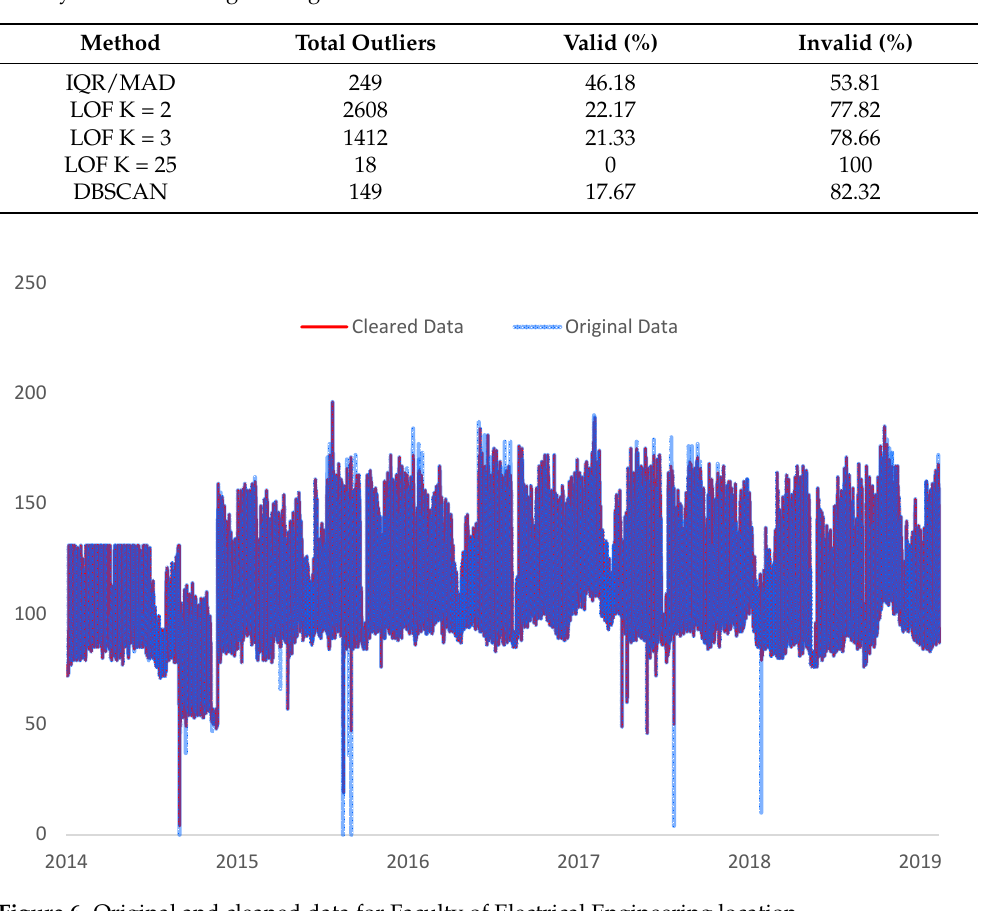
Figure 6. Original and cleaned data for Faculty of Electrical Engineering location. Table 3. Number of valid/invalid outliers detected using the implemented scoring method for Faculty of Electrical Engineering location.